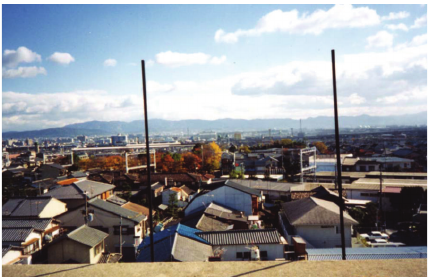
Figure 4: View toward Fushimi district shown in Figures 10 and 11 from the rooftop at which cochannel interference was measured.